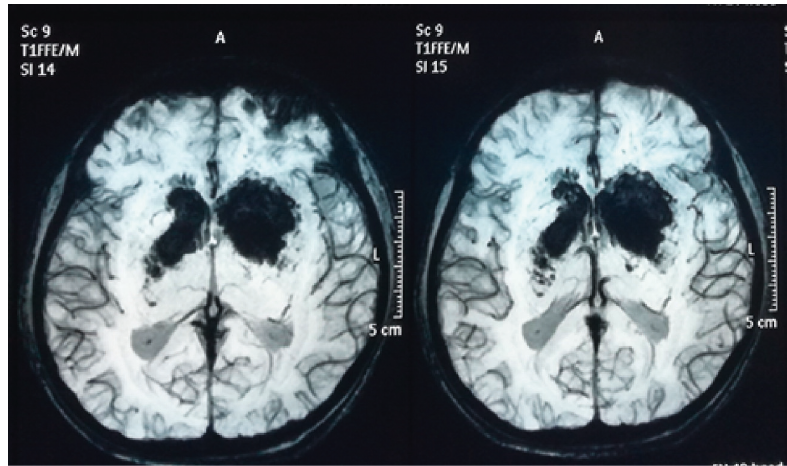
Figure 7: SWI image, an axial section at basal